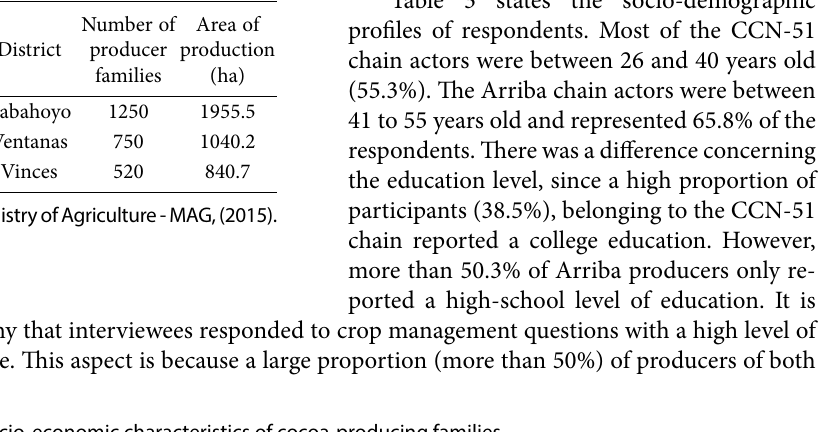
Table 3. Socio-economic characteristics of cocoa-producing